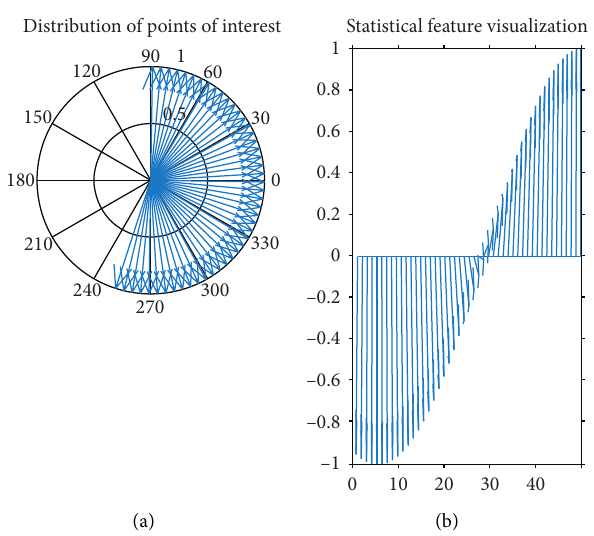
Figure 7: Statistical characteristics of action Jack.